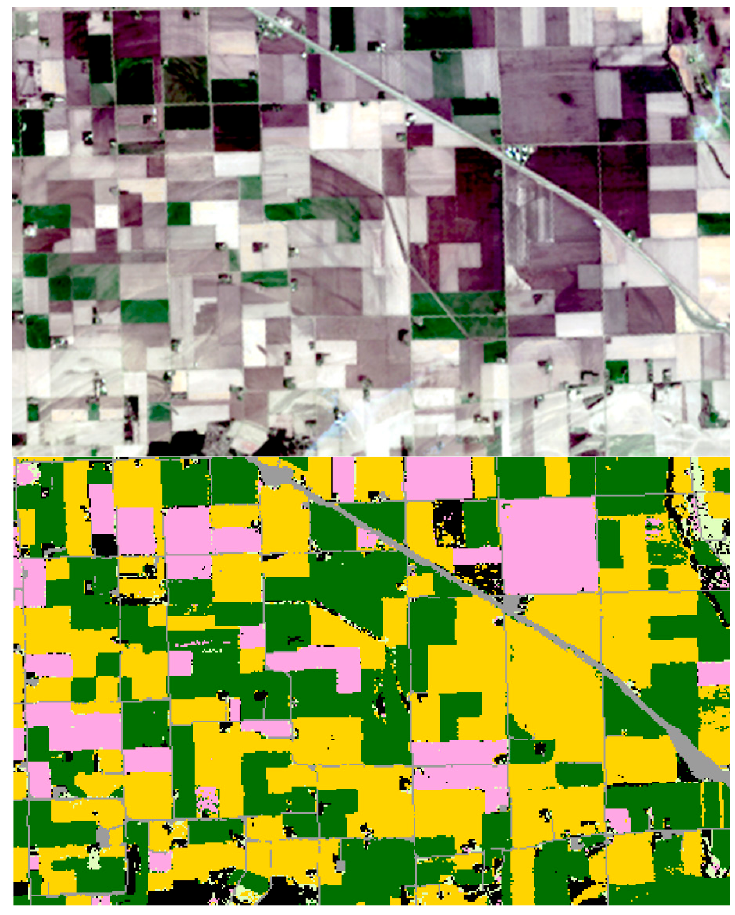
Figure 3. South Dakota (250 × 400 pixels). Bright green = soybeans (35.15%); yellow = corn (38.86%); gray = developed or open space (5.67%); pale green = grass/pasture (2.10%); magenta = alfalfa (12.94%); black = background (CDL classes corresponding to ≤ 2% of the study area).